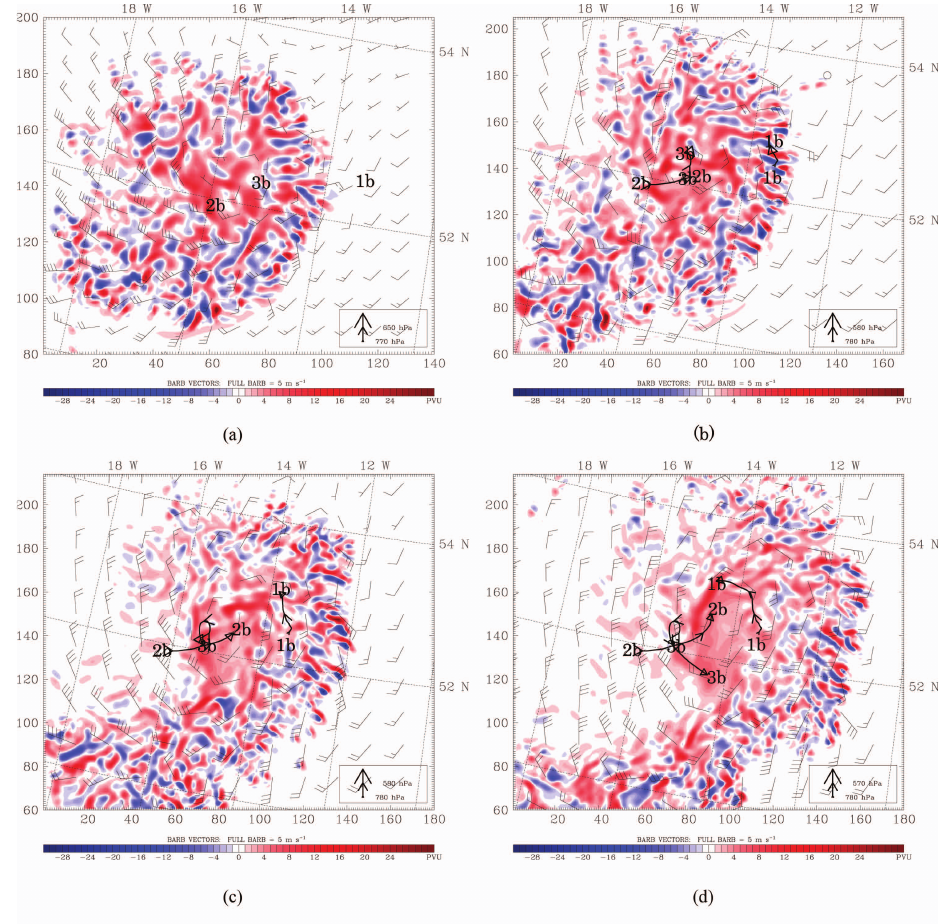
Fig. 7. Back-trajectory analysis and evolution of the PV (m 2 s − 1 Kkg − 1 ) and winds (kt) on the 3km domain of the MM5 CAPE simulation at the following times during the simulation: (a) 156.8h; (b) 158.4h; (c) 160.0h; and (d) 161.6h. The markings “1b”, “2b”, and “3b” refer to three trajectories ending in individual PV centers diagnosed at t =161.6h into the simulation. The back-trajectories were calculated from t =161.6h to t =156.8h, and the curved arrows indicate the same back-trajectories, forward, from t =156.8h to the valid time of the PV and wind analysis. Arrows along the trajectories are drawn at intervals of